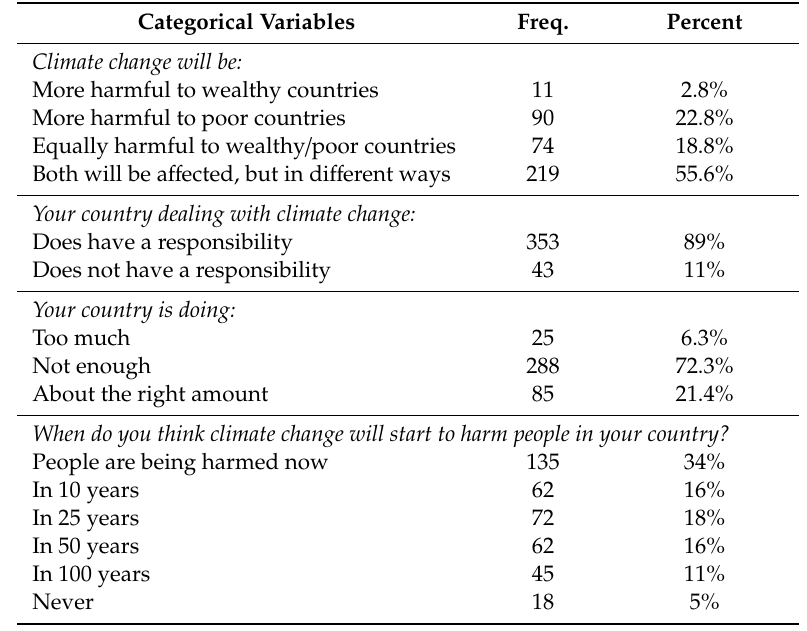
Table 3. Frequencies for nominal